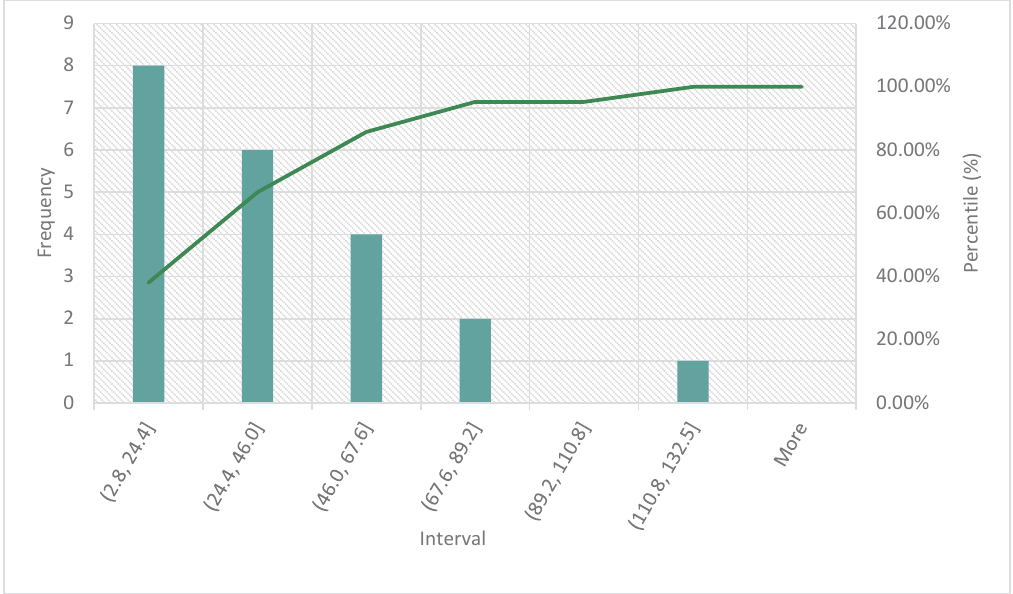
Fig. 6: Histogram and Pareto Graphic for Chlorophyll-a in Polk County